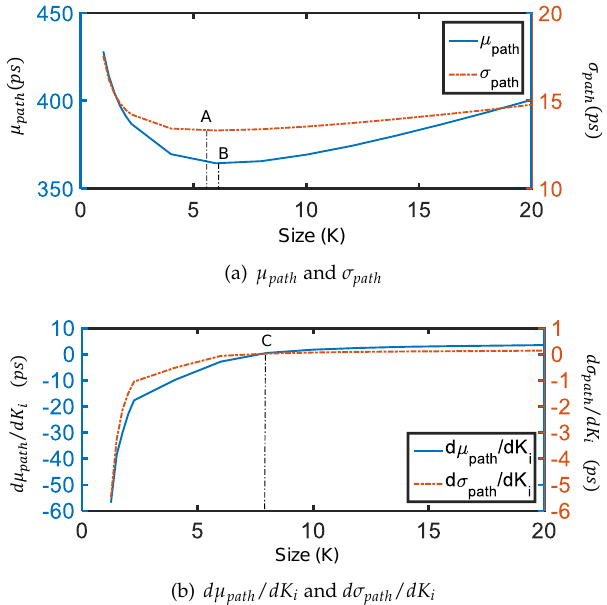
Figure 4. ( a ) Mean and standard deviation of the delay of the logic path in Figure 2 when gate G i is sized-up; ( b ) derivative of the mean and standard deviation of the delay of the